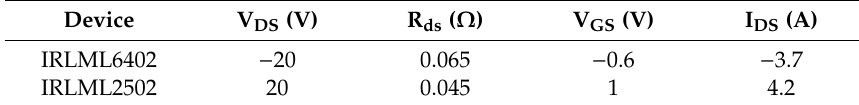
Table 2. Electrical specifications of MOSFETs.